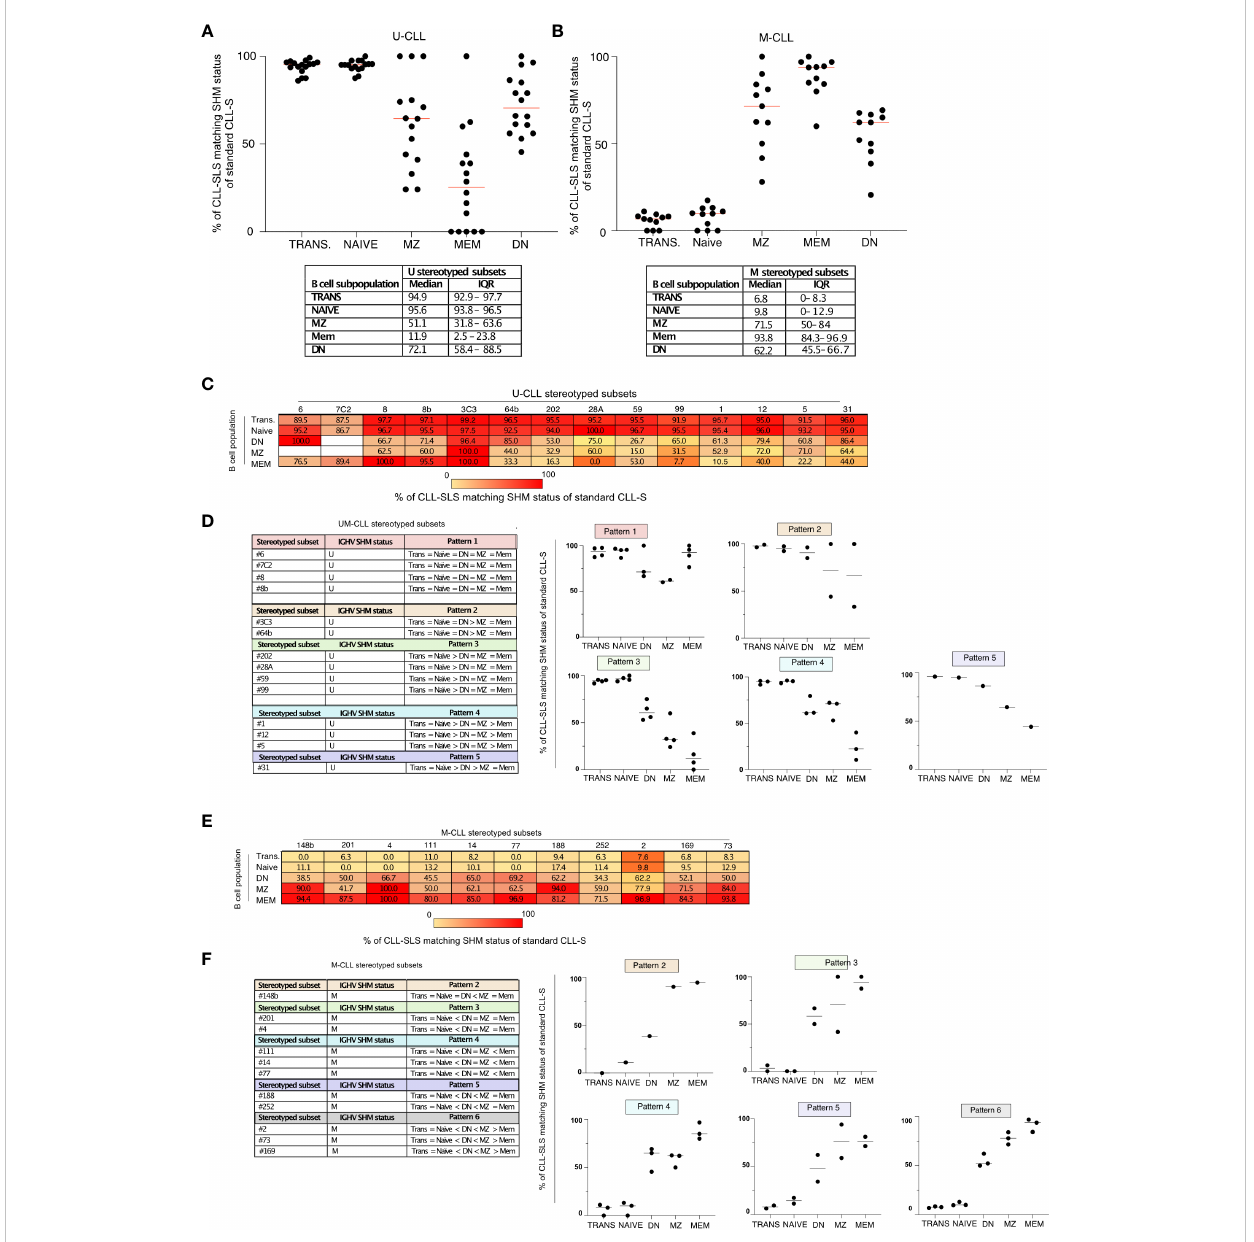
FIGURE 6 (A) Summary plot of the frequencies of IGHV-unmutated CLL-SLS with matching U-CLL stereotyped subsets (median). (B) Summary plot of the frequencies of IGHV-mutated CLL-SLS with matching M-CLL stereotyped subsets (median). (C) Table with median frequencies of IGHV-unmutated CLL-SLS with matching U-CLL stereotyped subsets divided by subsets. (D) Left panel: CLL-SLS attributed to U-CLL subsets were grouped in pattern based on the matching frequencies. Right panel: Plots showing the median frequency of CLL-SLS matching U-CLL status. Each plot represents one of the patterns indicated in the left panel. (E) Table with median frequencies of IGHV-mutated CLL-SLS with matching M-CLL stereotyped subsets divided by subsets. (F) Left panel: CLL-SLS attributed to M-CLL subsets were grouped in pattern based on the matching frequencies. Right panel: Plots showing the median frequency of CLL-SLS matching M-CLL status. Each plot represents one of the patterns indicated in the left